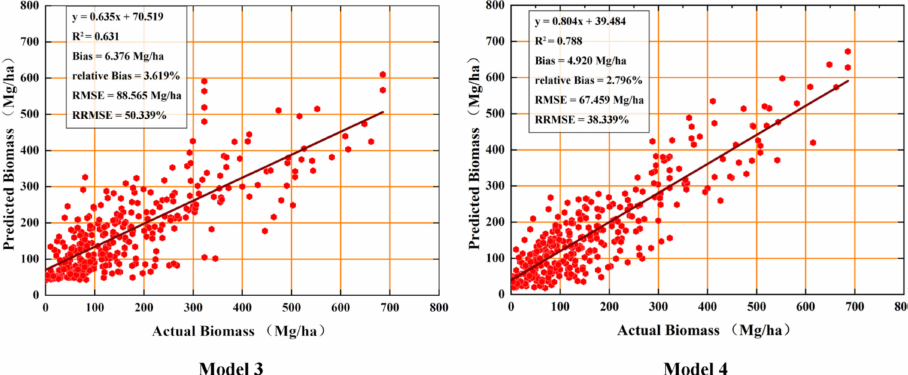
Figure 5. Accuracy evaluation of the tropical rainforest biomass estimation model (Model 3 and Model 4) for remote